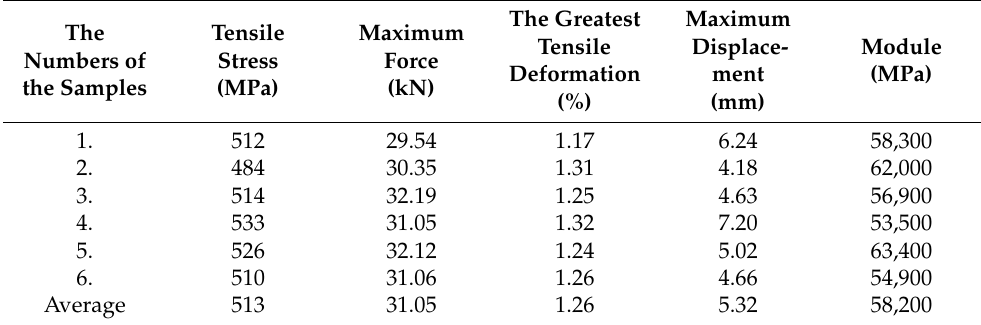
Table 5. Analysis of the obtained test results for the composite laminate reinforced with the IMS65